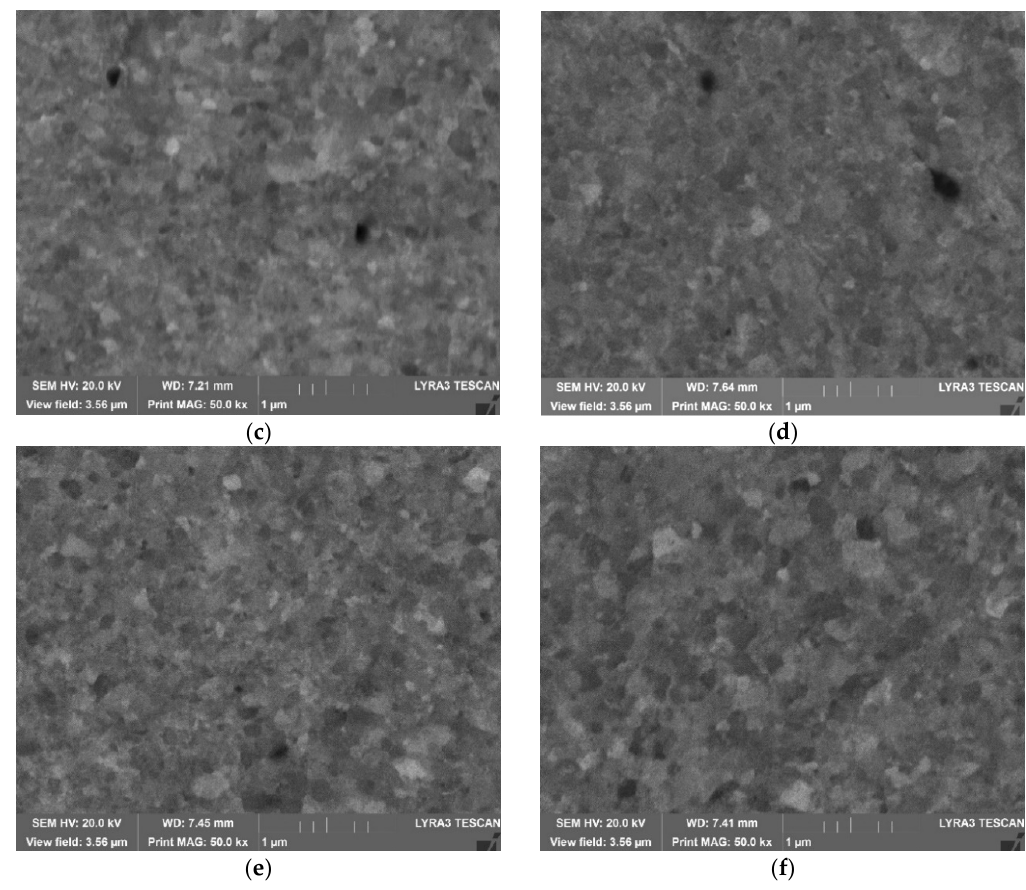
Figure 2. Microstructures of the consolidated ( a ) OP1, ( b ) OP2, ( c ) OP3, ( d ) OP4, ( e ) OP5 and ( f ) OP6.